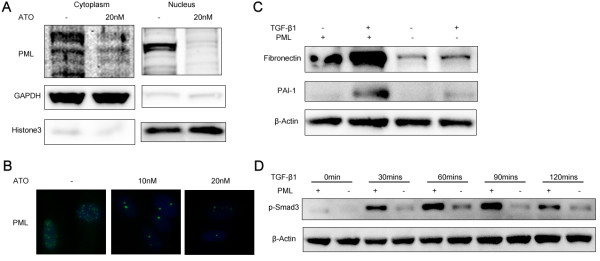
TGF-β1 induced PAI-1, fibronectin and Smad3 phosphorylation are impaired in PML -/- MEFs. (A) NHLFs were treated with ATO (20nM) for 24 hrs. Cytoplasmic and nuclear compartments were separated and extracted. PML protein expression was decreased in both the cytoplasm and nucleus in response to ATO treatment. (B) Immunofluorescent staining shows that PML bodies in NHLFs were decreased in response to ATO treatment. (C) Wild type and PML-/- mouse embryonic fibroblasts (MEFs) were treated with TGF-β1 (1 ng/ml) for 24 hrs. Fibronectin-EDA and PAI-1 protein expression was induced by TGF-β1 in WT-MEFs but not PML -/- MEFs. (D) Wild-type and PML -/- MEFs were treated with TGF-β1 (1 ng/ml) and cells were harvested at the indicated time points. Smad3 phosphorylation was induced in WT-MEFs and the level of phosphorylation was markedly decreased in PML -/- MEFs. Western blot data represents consistent trend in three independent repeats with the best image quality.